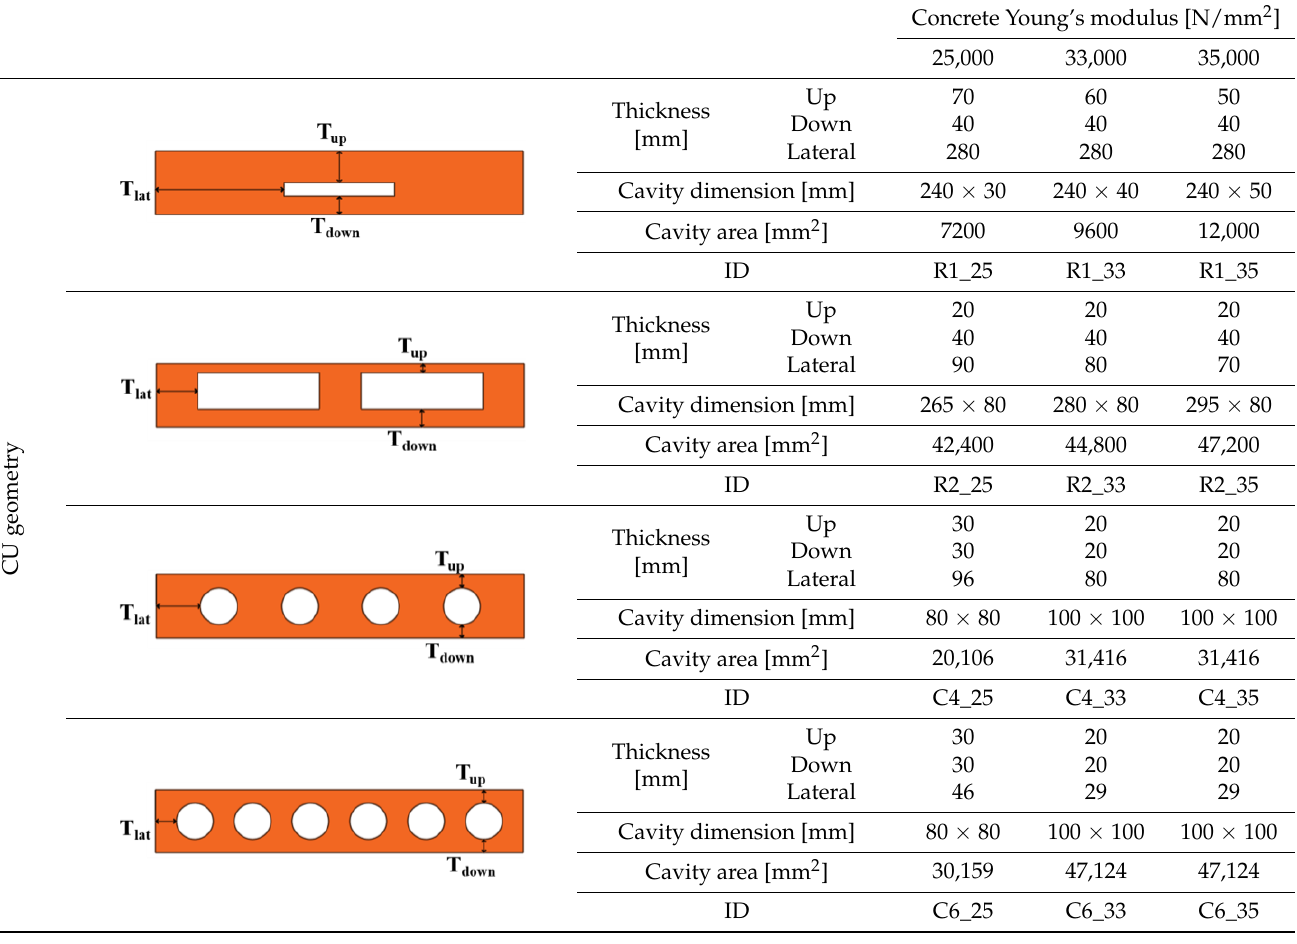
Table 2. Combination of CU geometry and concrete Young’s modulus.